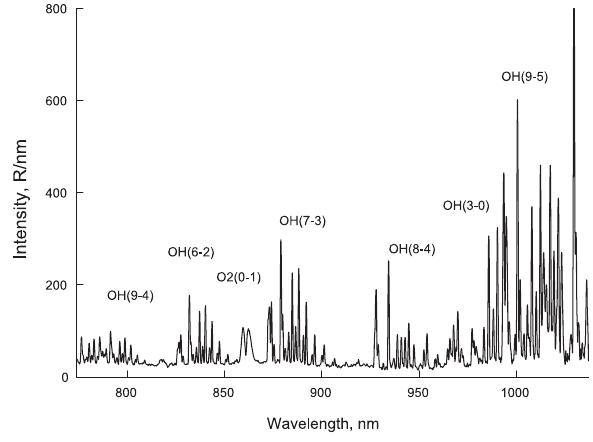
Fig. 1. Spectrum of the night airglow observed at Zvenigorod Ob- servatory on 19 May